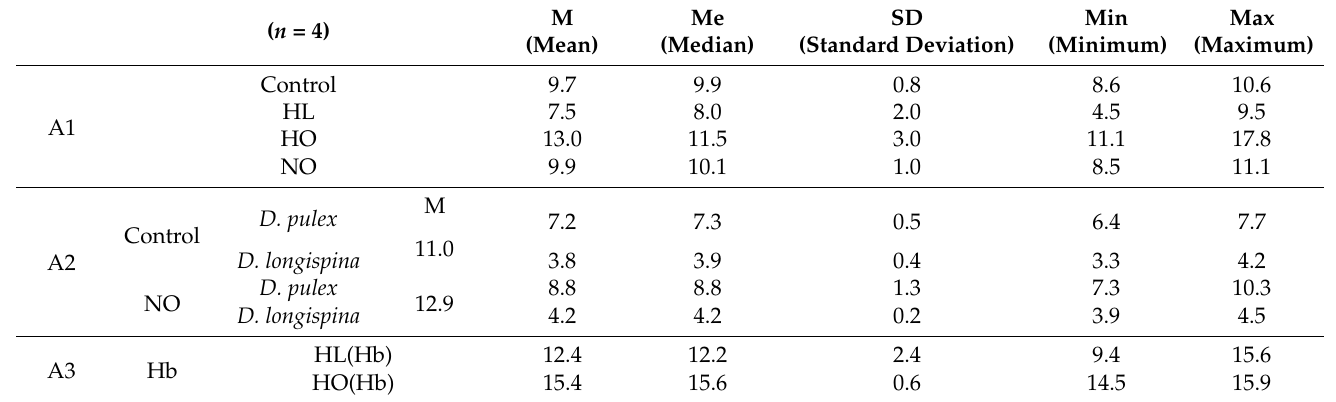
Table 1. Results of the experiments testing Hypotheses 1, 2, 3.